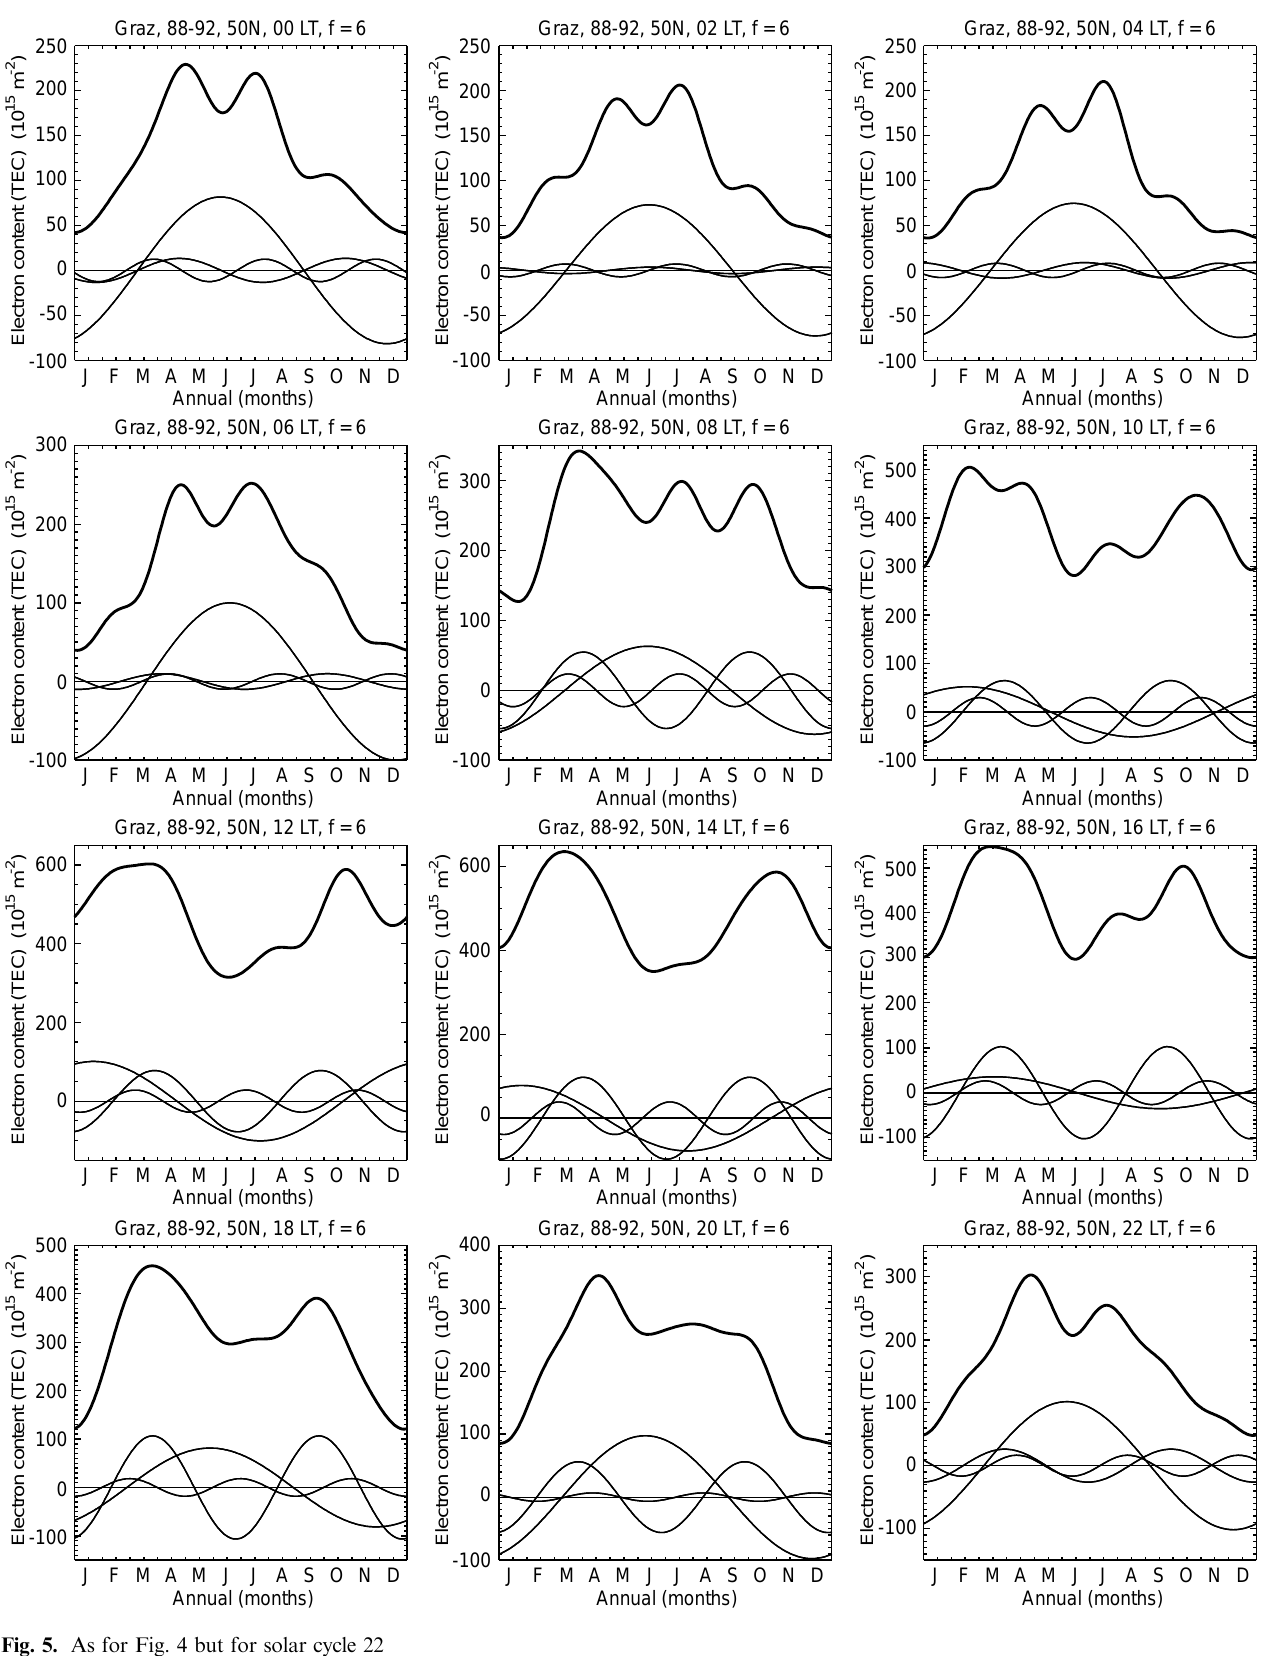
Fig. 5. As for Fig. 4 but for solar